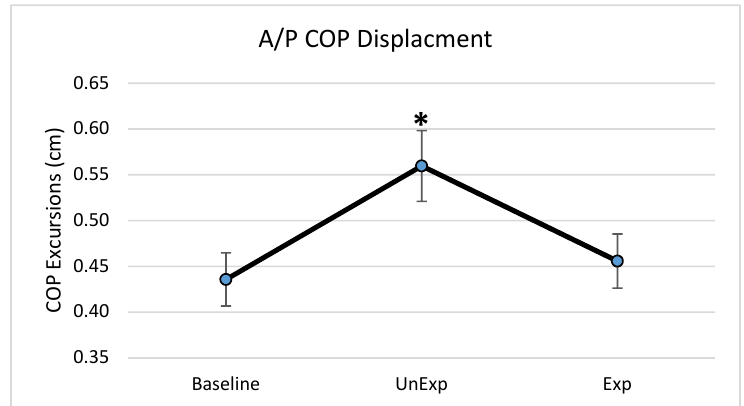
Figure 5. Center of pressure anterior–posterior excursions (cm) during baseline, unexpected (UnExp) moving wall, and expected (Exp) moving wall conditions. Bars represent standard errors. * represents a significant difference at p < 0.05 compared to the baseline condition.